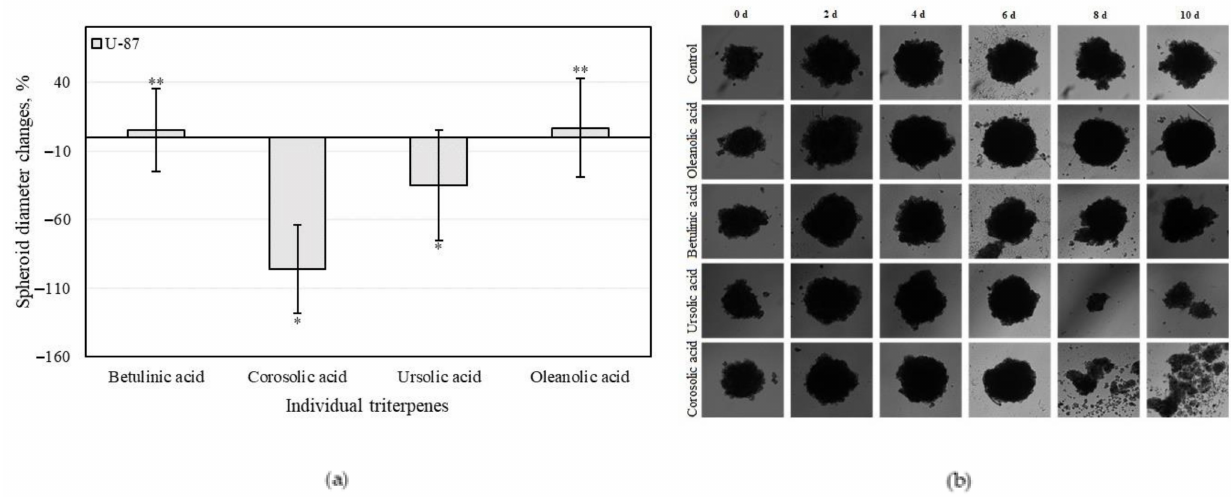
Figure 11. The effect of individual triterpenes on U-87 cell spheroid growth: ( a ) spheroid diameter changes; ( b ) spheroid disintegration. Different signs (*) indicate statistically significant differences at p > 0.05, according to Tukey’s multiple comparison